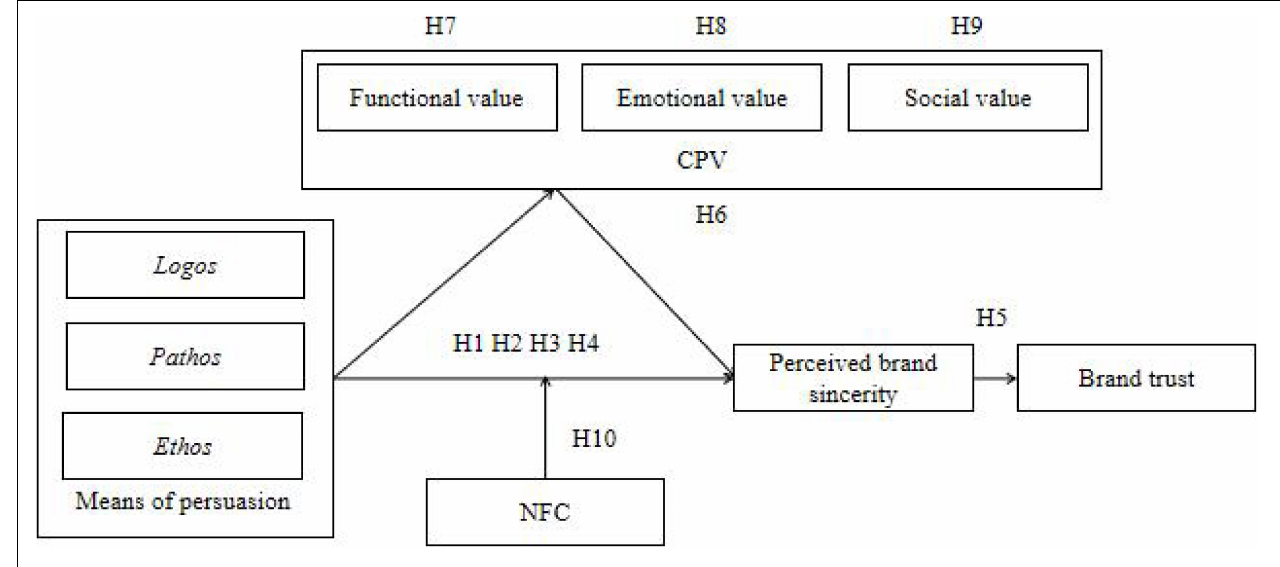
FIGURE 1 | Research model.